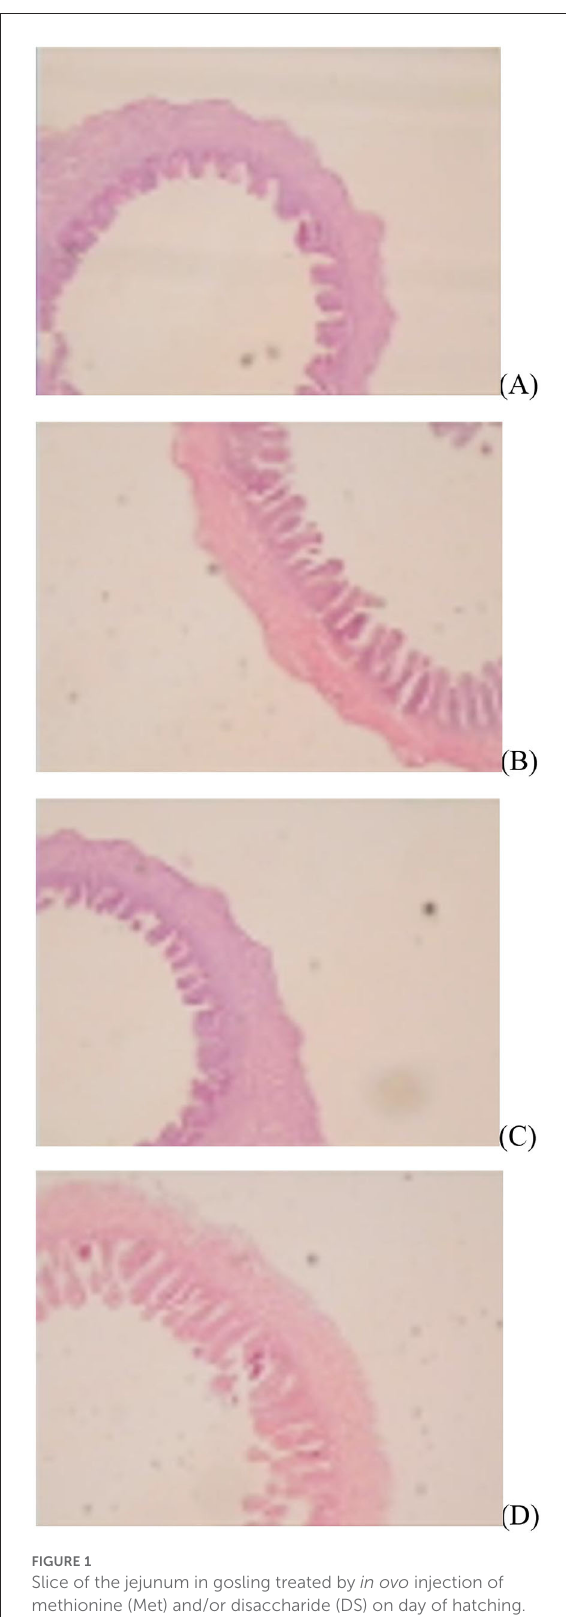
FIGURE2 Slice of the jejunum in gosling treated by in ovo injection of methionine (Met) and/or disaccharide (DS) on day 7 post-hatching. (A) Non-injection group; (B) DS injection group; (C) Met injection group and (D) DS plus Met injection